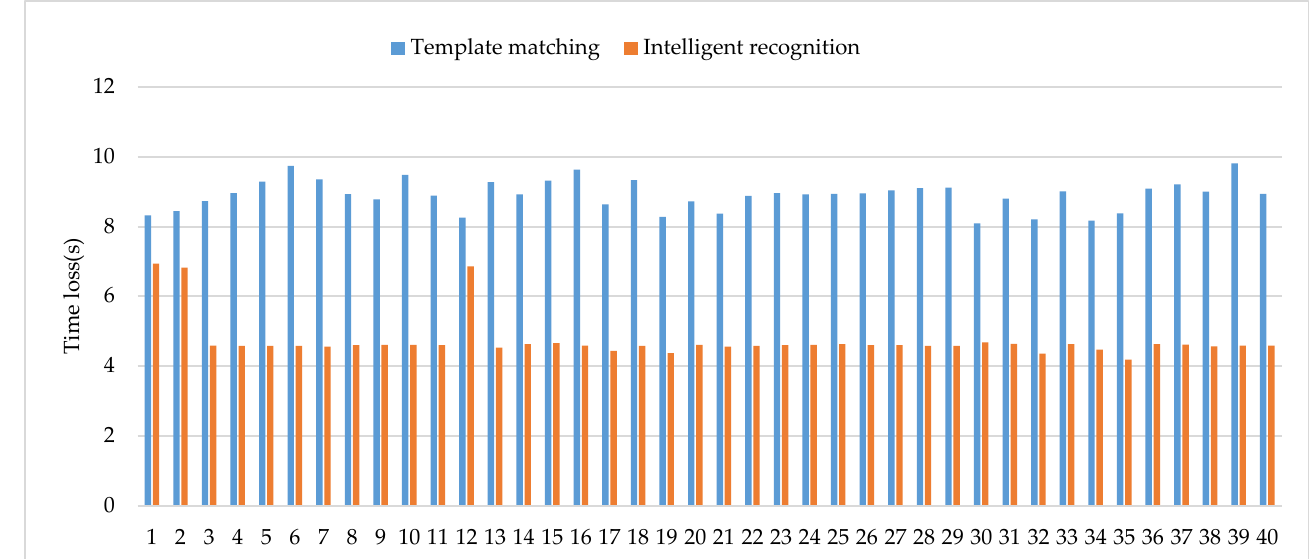
Figure 22. Comparison of water level values. The green line shows the values by visual reading. The yellow line represents the values of intelligent recognition. The bule line represents the values by the method of template matching. The abscissa represents the sequence number of the image and the ordinate represents the value of the reading (the unit is m).